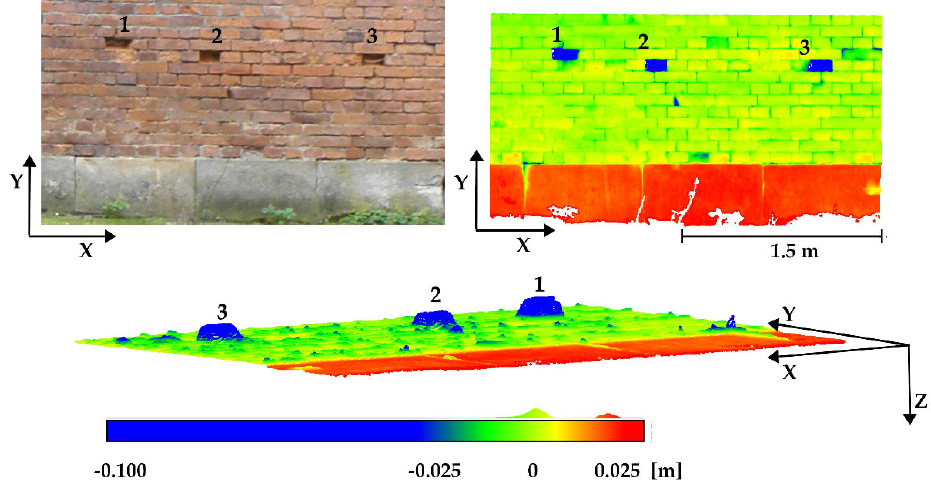
Figure 5. Detection of cavities (missing bricks) in the wall.